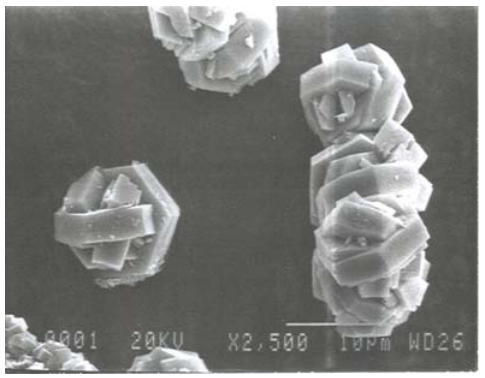
Figure 6. Electron micrograph of intergrown hexagonal troilite